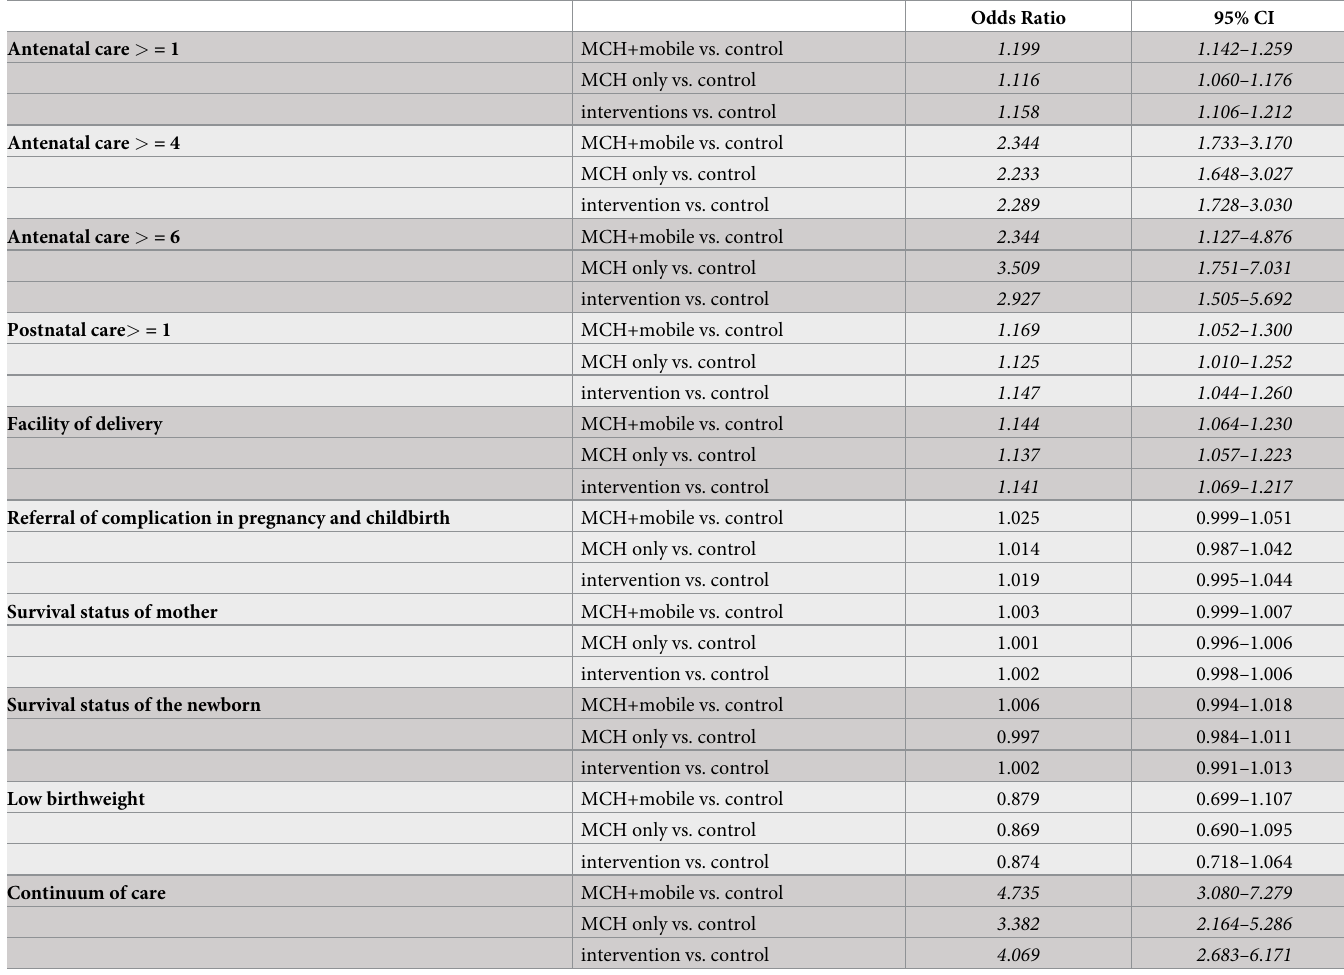
Table 2. Univariate analysis for effects of the interventions on the expected